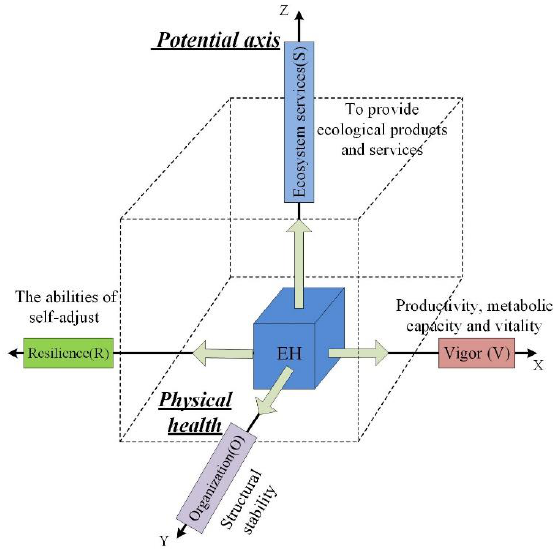
Figure 2. Framework of ecosystem health assessment.